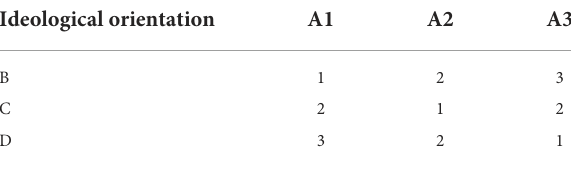
TABLE 3 Compatibility between specific ideological orientation and specific alternatives of choice. Ideological